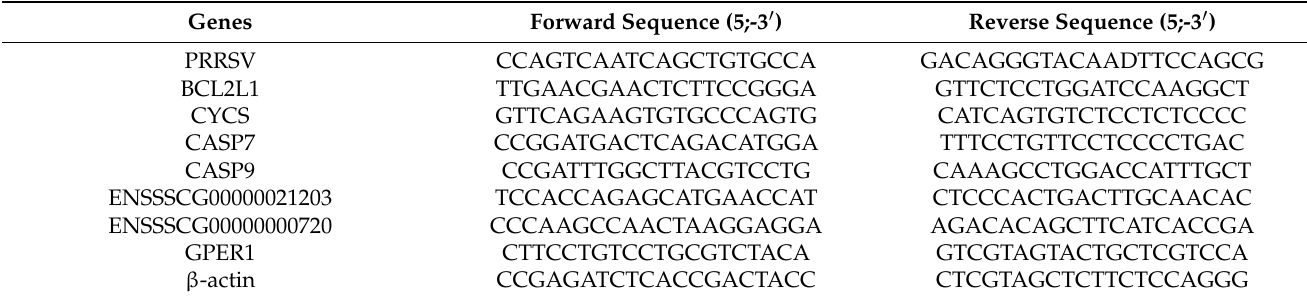
Table 2. Primers used in this